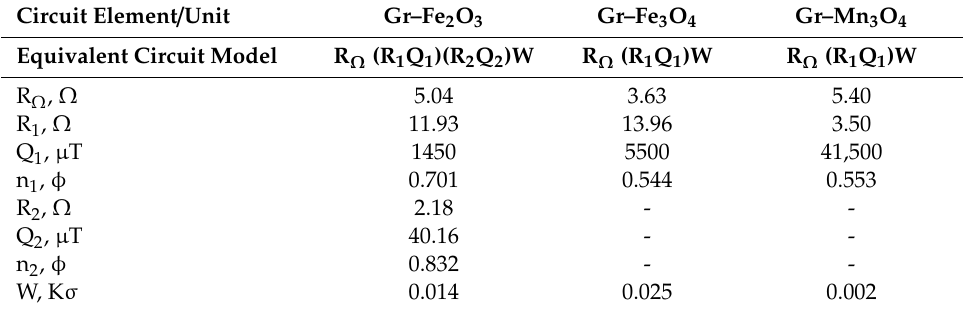
Table 1. Parameters of the equivalent circuit models obtained by fitting of impedance spectra presented in Figure